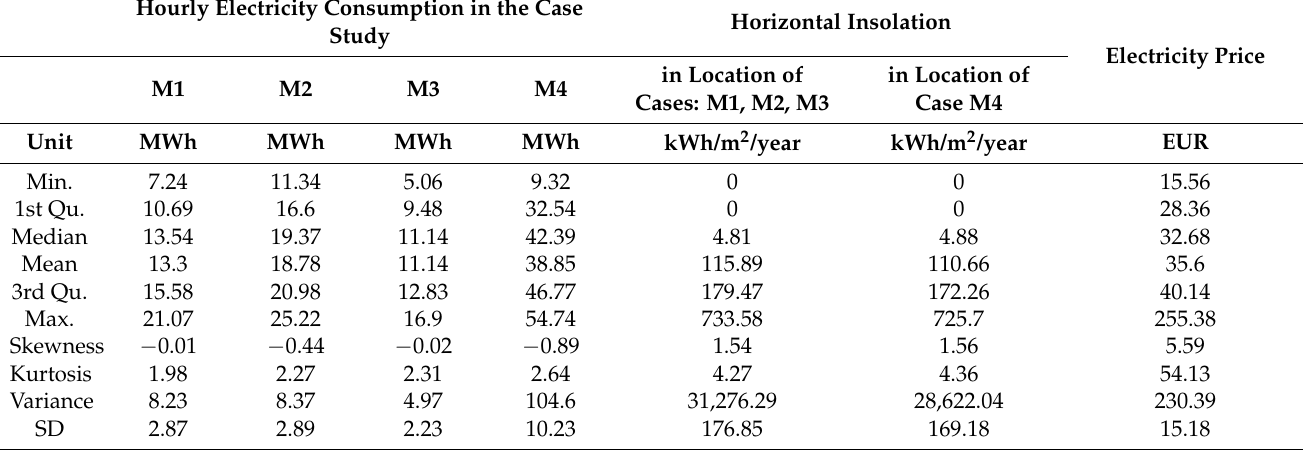
Table 1. Descriptive statistics of the analyzed variables for 4 analyzed research objects and insolation in their locations and electricity prices in